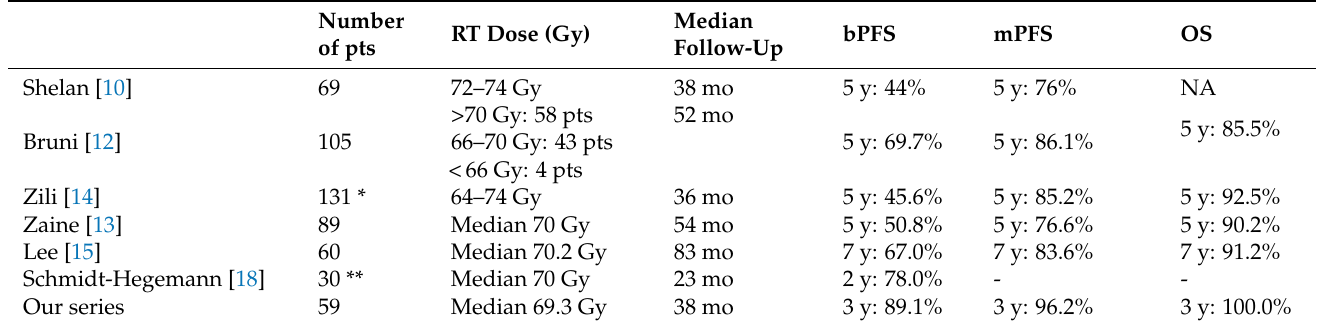
Table 4. Comparative literature